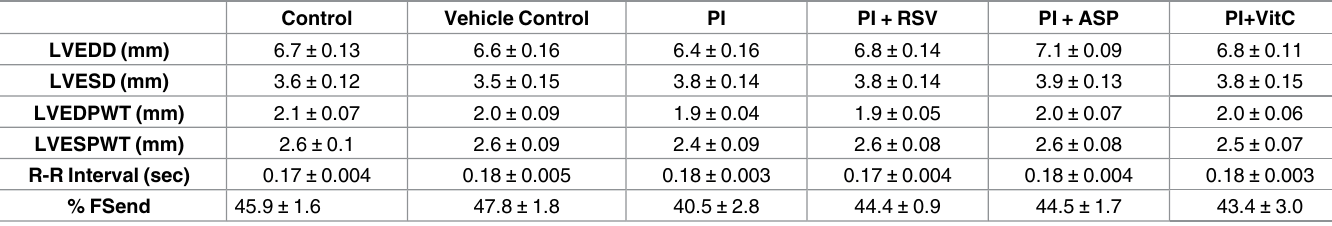
Table 3. Left Ventricular Parameters as Measured with Echocardiography after 4 Months of Treatment. Control